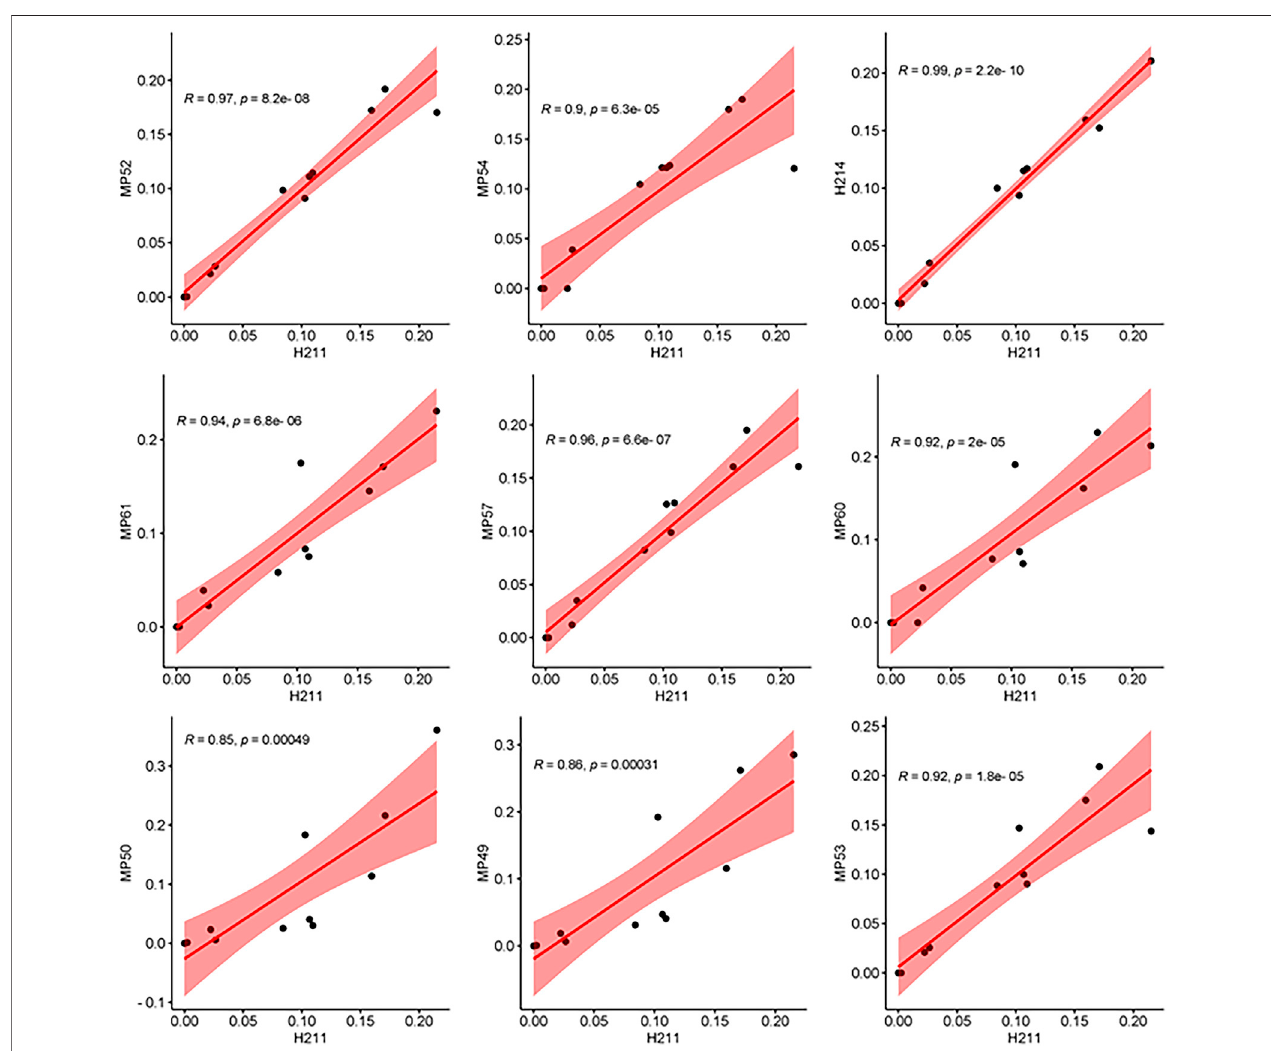
FIGURE 4 | Pearson correlation analysis between the main exposed compounds and